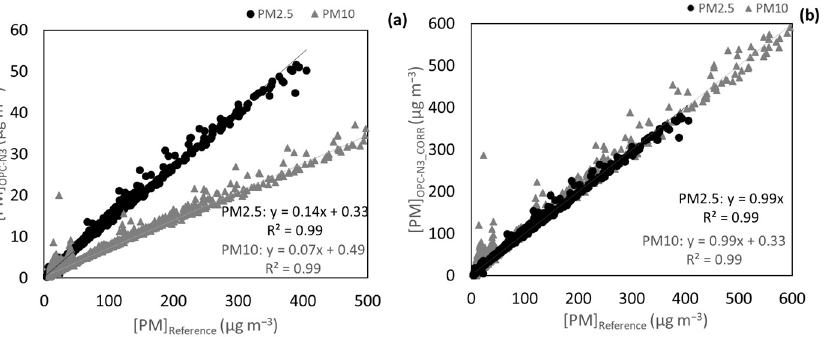
Figure 4. ( a ) SLR of the concentrations measured by the OPC-N3 and DustTrak 8533 for PM2.5 and PM10 and ( b ) consequent correction. Measurements done in a laboratory setting.